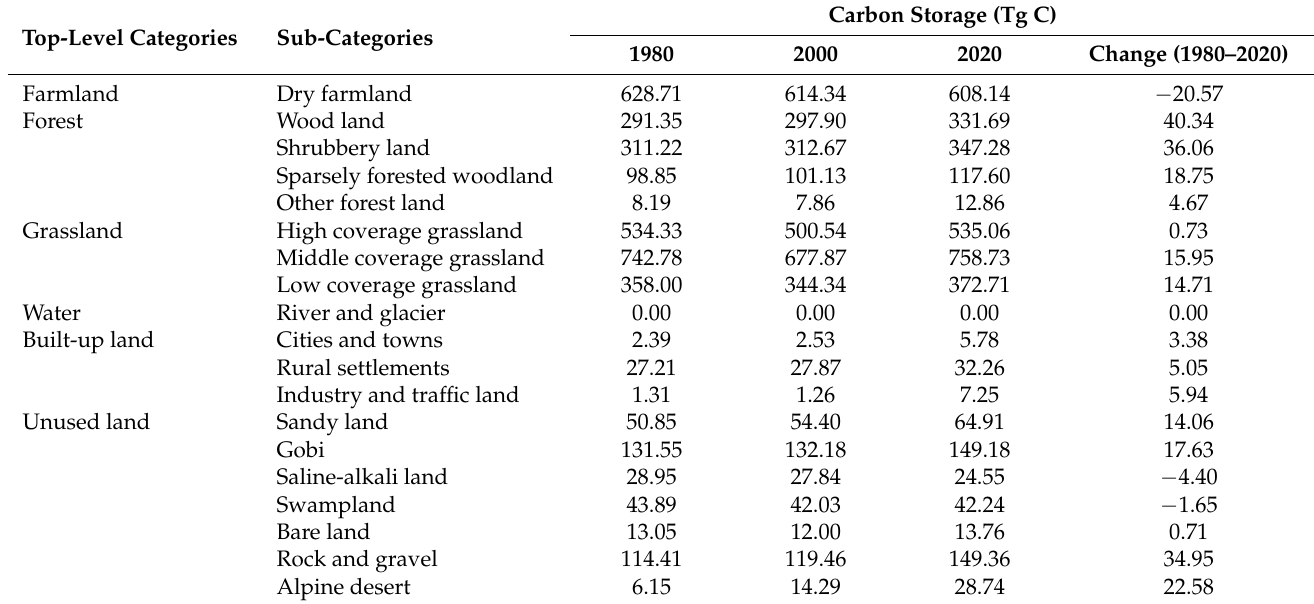
Table 4. Carbon storage changes in the Gansu province from 1980 to